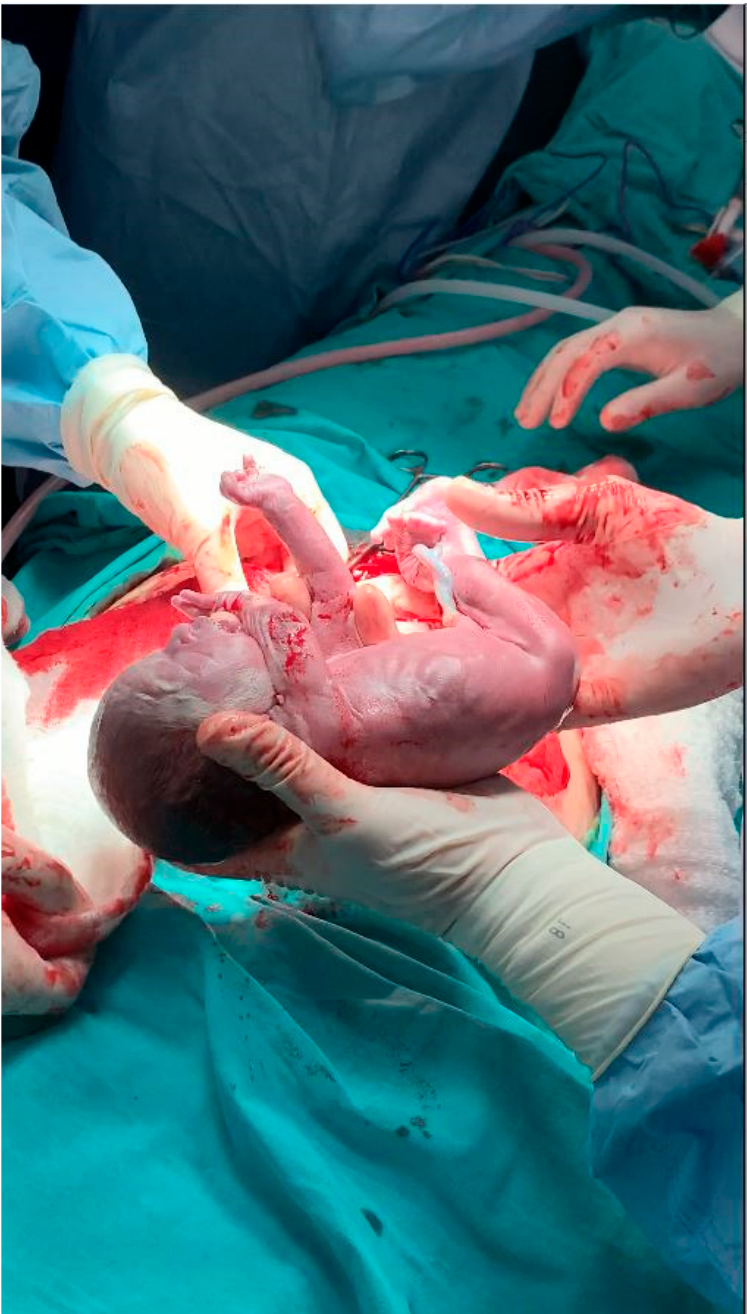
Figure 2. Birth of the baby from first successful uterus transplant.